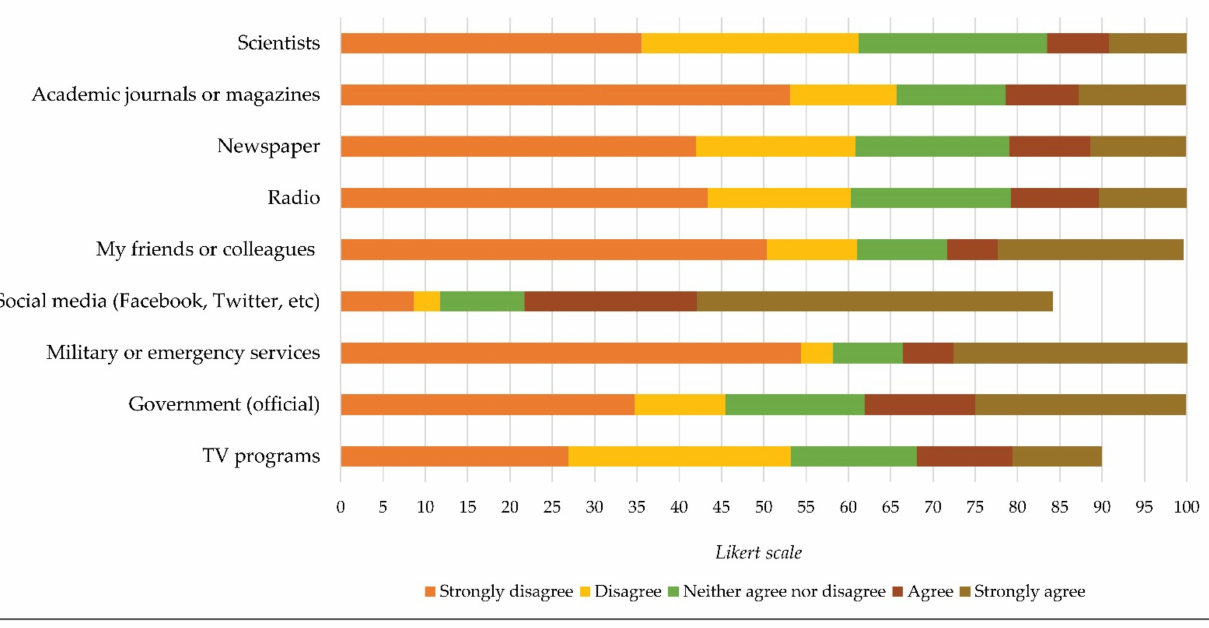
Figure 6. Reliable sources to acquire information about coronavirus disease